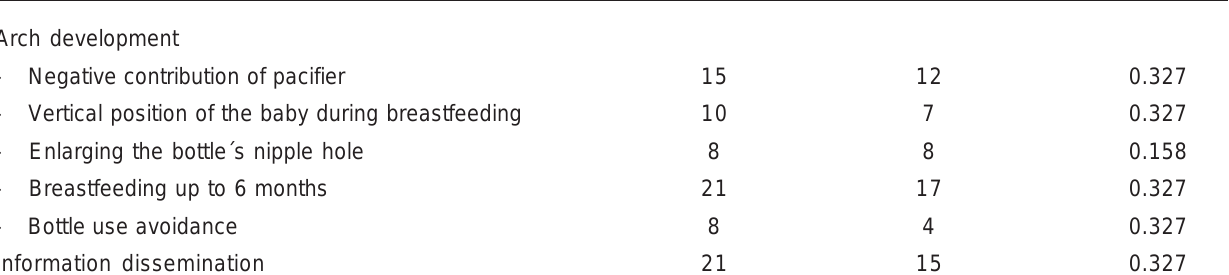
A tendency was observed for the mothers to forget the advice to restrict sugar intake as time went on. This result suggests the need to schedule preventive dental visits even before the first tooth appears in order to remind mothers about adequate weaning, since eating habits are established early in the life of a child 11,18 .